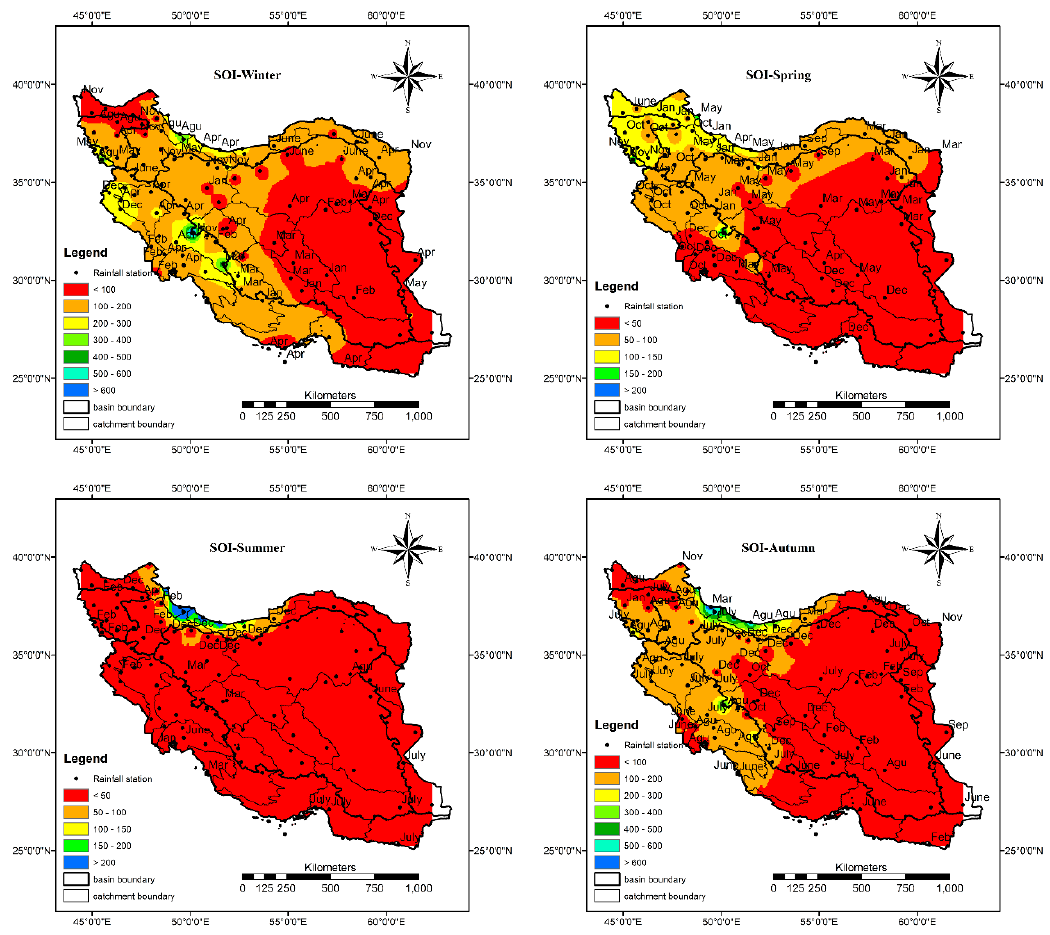
Figure 5. The month of SOI, PDO, and NAO with highest correlation with seasonal precipitation.The background is the long-term seasonal precipitation.